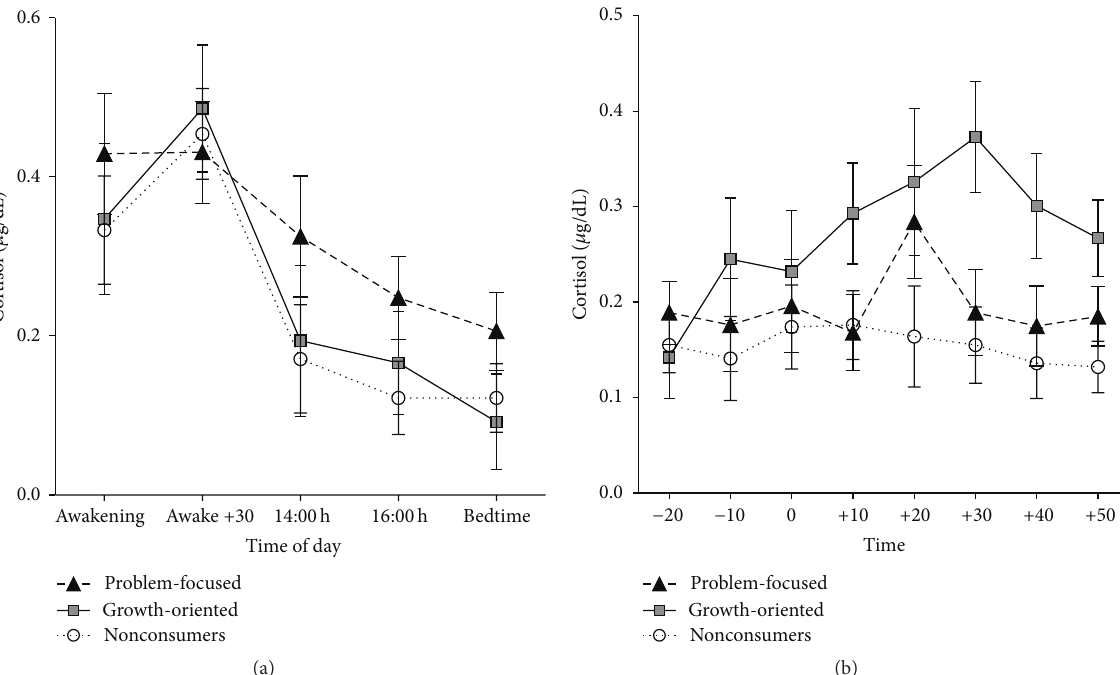
Figure 1: Repeated-measures of (a) diurnal cortisol and (b) reactive cortisol as a functioning of groups based on preference for problem- focused or growth-oriented self-help books. These graphs are used strictly to represent the mean (standard error bars) cortisol concentrations and to show the magnitude of the cortisol response to the TSST in each of the groups tested. As such, they have no relation to the statistical model employed that otherwise used the composite measure of area under the curve for cortisol levels (basal, reactive, and